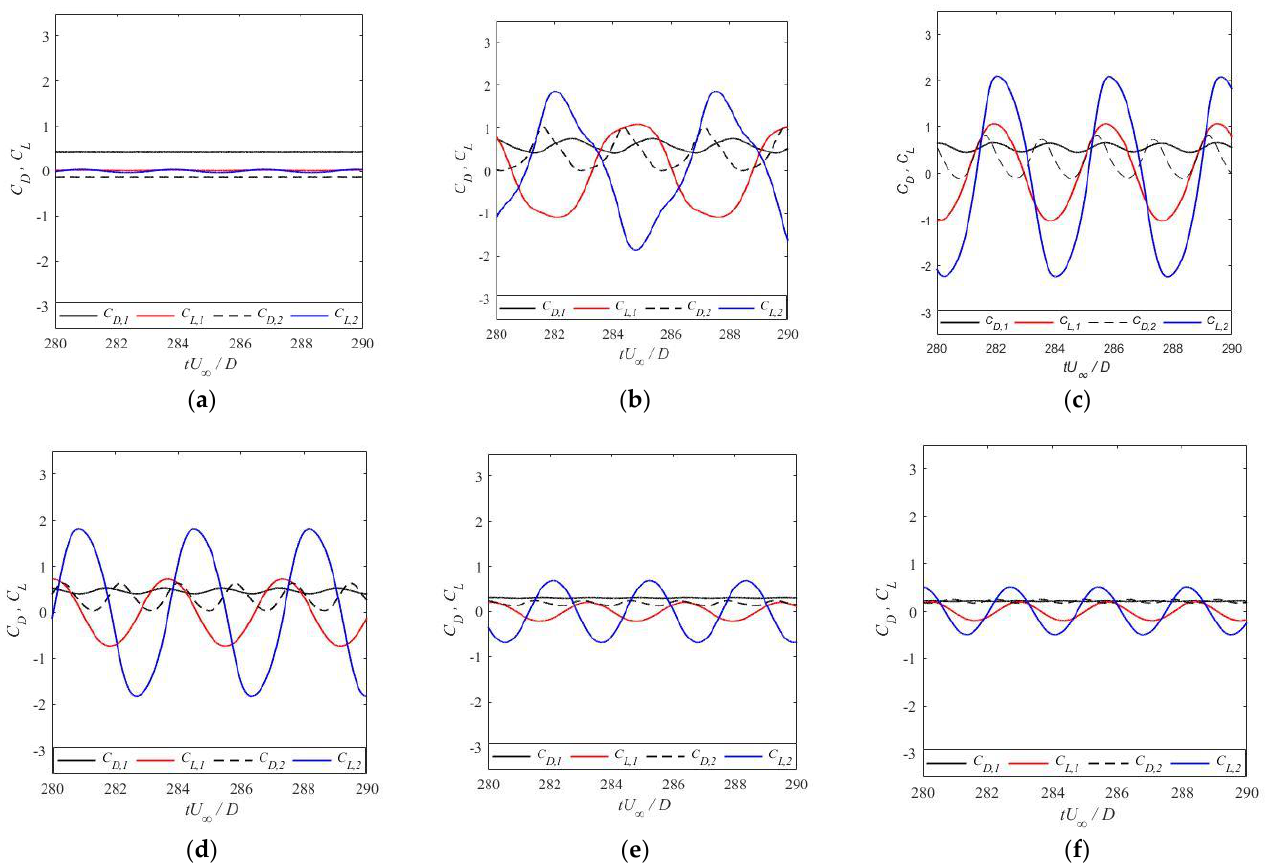
Figure 4. Time histories of 𝐶 𝐿 and 𝐶 𝐷 for different distance ratios: ( a ) 𝐿/𝐷 = 1.56 , ( b ) 𝐿/𝐷 = 1.8 , ( c ) 𝐿/𝐷 = 2.5 , ( d ) 𝐿/𝐷 = 3 , ( e ) 𝐿/𝐷 = 3.7 , ( f ) 𝐿/𝐷 = 4 . ( c ) L / D = 2.5, ( d ) L / D = 3, ( e ) L / D = 3.7, ( f ) L / D =